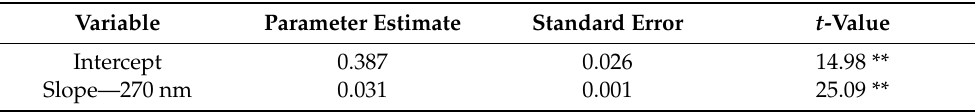
Figure 2. Association between absorbance at 270 nm and 7-epi zingiberene concentration (ng/µL) measured by GC-FID of hexane leaflet washes from BC4F2 interspecific hybrid plants, n = 38. Table 1. Estimates of intercept, slope, and their respective standard errors and t -values for the regression of absorbance at 270 nm on 7-epi zingiberene content measured by GC-FID for 38 BC2F2 interspecific hybrid tomato individuals.